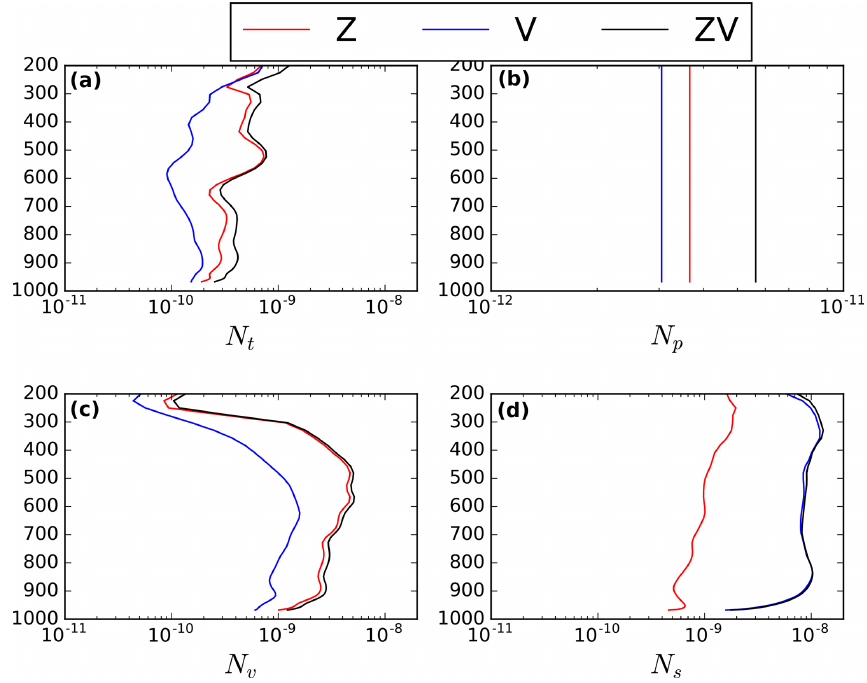
Figure 9. Temperature N T (a) , surface pressure N p (b) , humidity N v (c) and kinetic N s (d) contribution terms of the exergy distance as a function of the altitude for the Z SOP1 (red curve), V SOP1 (blue curve) and ZV SOP1 (black curve)